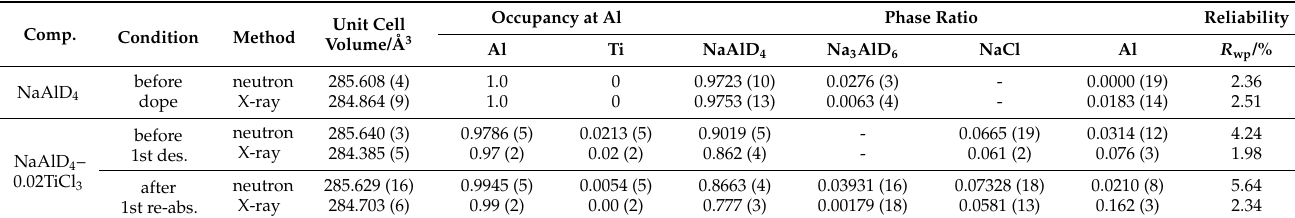
Figure 1. Hydrogen pressure–composition ( p – c ) isotherm of deuterium desorption of NaAlD 4 –0.02TiCl 3 at 398, 403, and 408 K. Table 1. Summary of Rietveld refinement of NaAlD 4 and NaAlD 4 –0.02TiCl 3 before the desorption and after the re-absorption of